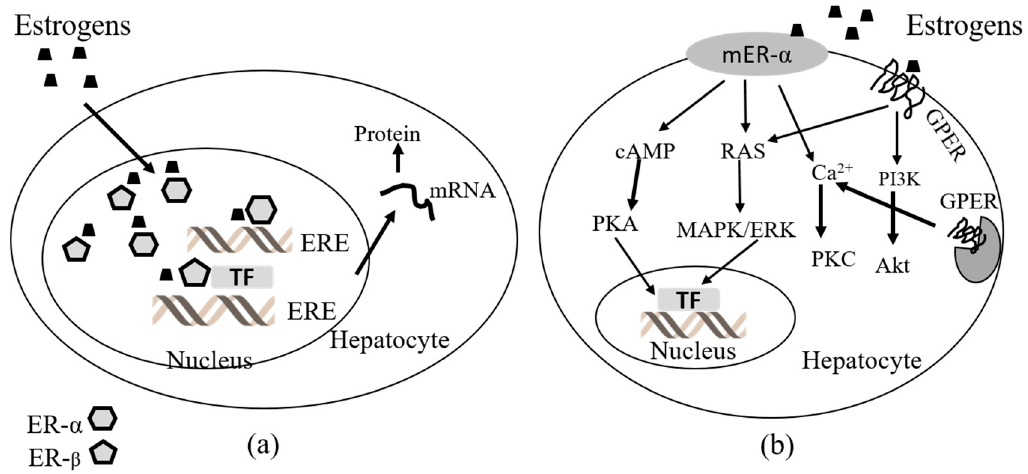
Figure 2. Intracellular pathways of estrogens via estrogen receptors (ERs) in hepatocyte cells. ( a ) Genomic effects of estrogens via nuclear ERs. ( b ) Non-genomic effects of estrogens via membrane- associated ERs. ERE = Estrogen response element; TF = Transcription Factor.